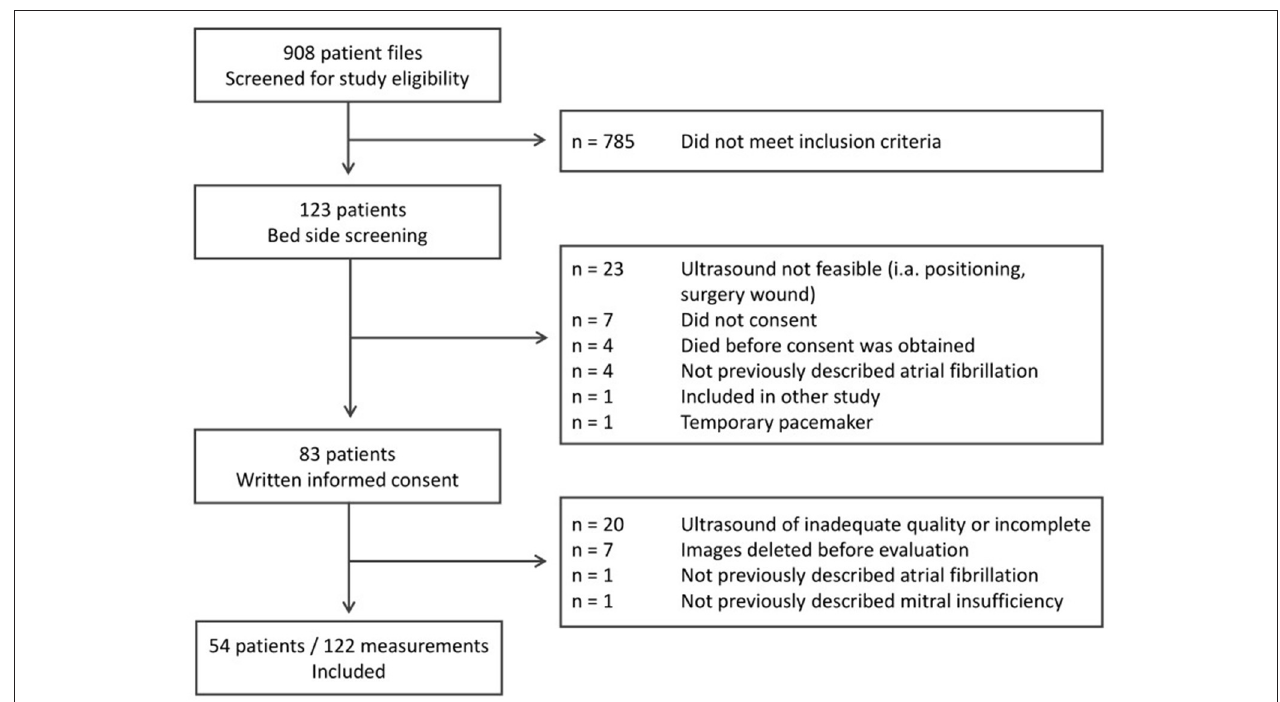
FIGURE 1 | Identification and inclusion of study participants for this prospective observational cohort